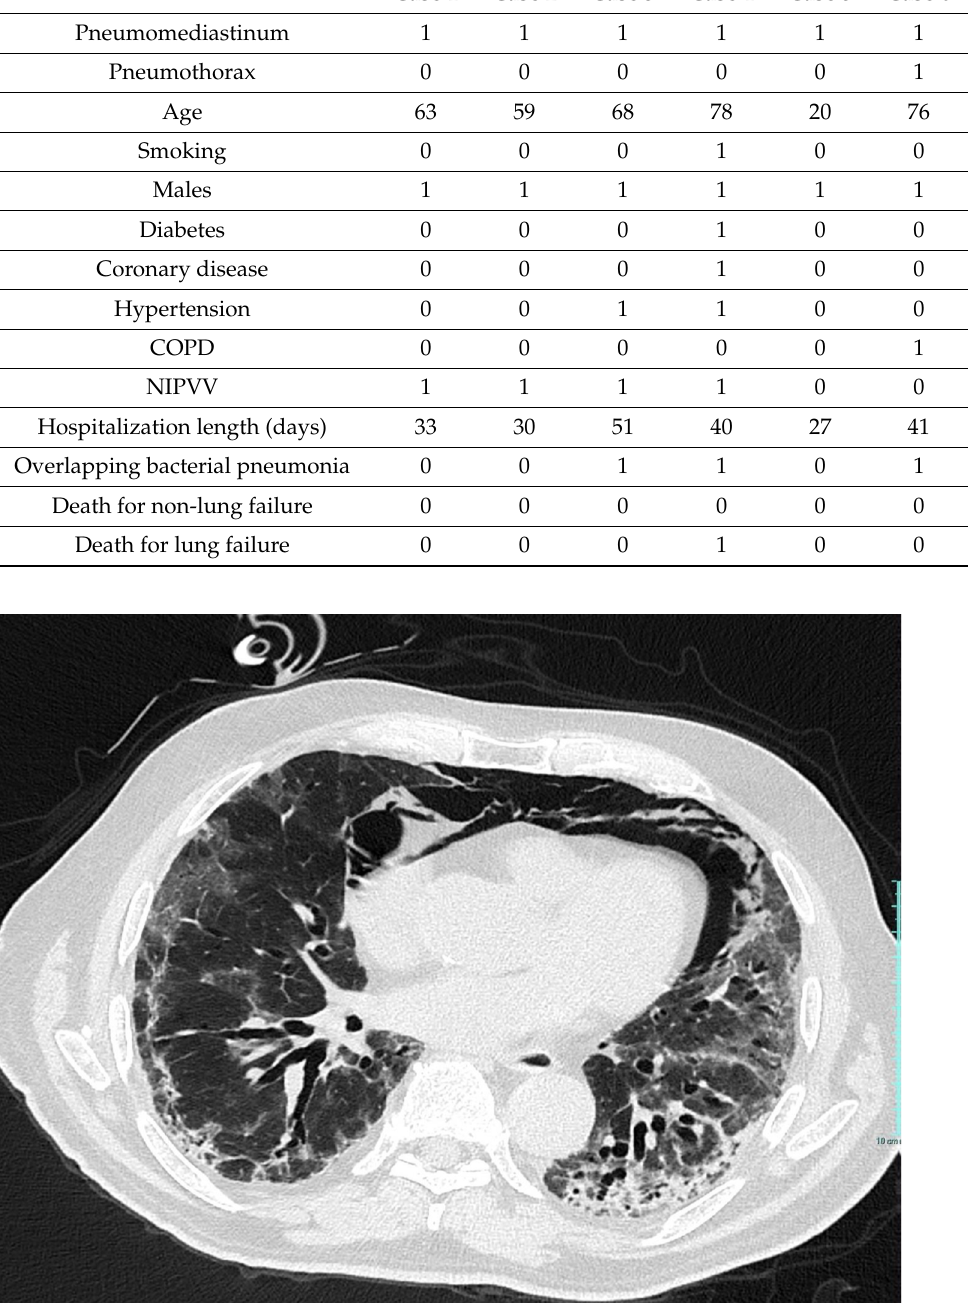
pneumomediastinum and pneumothorax is due to alveolar rupture secondary to severe diffuse alveolar and vascular endothelium damage. Episodes of coughing that increase the pressure in the chest, positive pressure ventilation, prone position therapy and steroid therapy may contribute to the development of pneumomediastinum and pneumothorax [14]. Yet, because during pandemic the demand for NIV for patients in the emergency room has been increasing day by day, we suggest considering the risk of pneumothorax and pneumomediastinum in those patients that do not show improvements during NIV. Fast identification of severe clinical complications, such as pneumothorax and pneumomediastinum, is fundamental as far as those of superimposed bacterial infections and/or pulmonary embolism. In our experience, the occurrence of pneumothorax and pneumomediastinum has been associated with prolonged hospitalization and worse outcomes when overall deaths or deaths due to lung failure are considered. Although this is a short clinical series, a few reports are present in the Medline regarding pneumothorax and pneumomediastinum with large cohorts. Therefore, our data need to be confirmed on a larger population, but based on this experience, we suggest considering pneumomediastinum and pneumothorax as relevant complications, not only